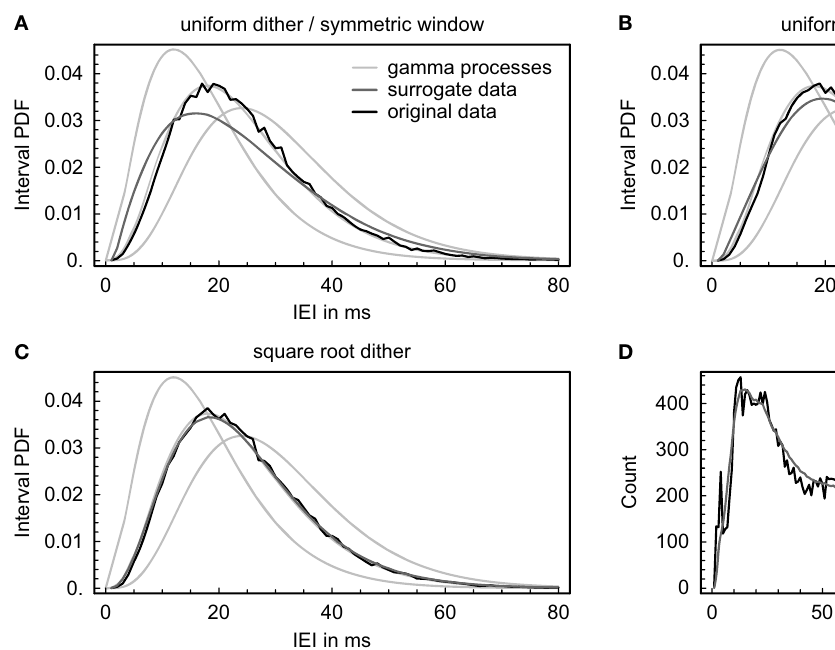
(B) Same as in (A) , but allowing for an asymmetric window.The average absolute displacement of an event resulted in 6.1ms. (C) Event times were dithered according to the “square root dither” method (Gerstein, 2004) again using a maximal window of ± 20ms and assuring a “refractory period” of 1ms between events.The average absolute displacement of an event resulted in 3.9ms. (D) Same as in (C) , but dithering was applied to real spike trains recorded simultaneously from 67 units.The resulting average distribution of inter-spike intervals (ISI) is shown in comparison with the original data (bin size = 1ms).The average absolute displacement of an event resulted in